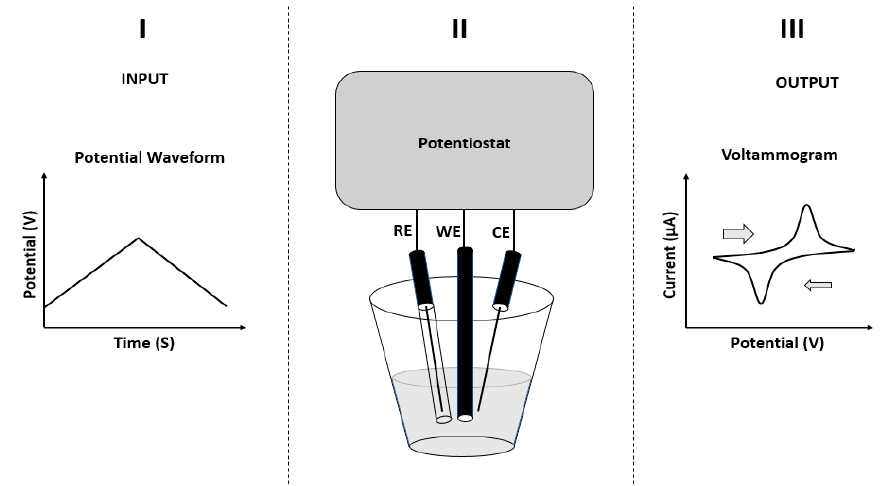
Figure 1. ( II ) Conventional cyclic voltammetry setup with potentiostat connecting to three electrodes: working electrode (WE), the counter electrode (CE), and the reference electrode (RE). The electrode tips are submerged under the analyte in a sample vial. ( I ) A sweeping voltage potential is applied by the potentiostat to the analyte via WE; the potential increases and then decreases in the “cycle” at a pre-set duration. ( III ) The current response from analyte is measured at the WE and plotted against applied voltage potential in a voltammogram. The broad arrow indicates anodic current response, and the thin arrow indicates cathodic current response.